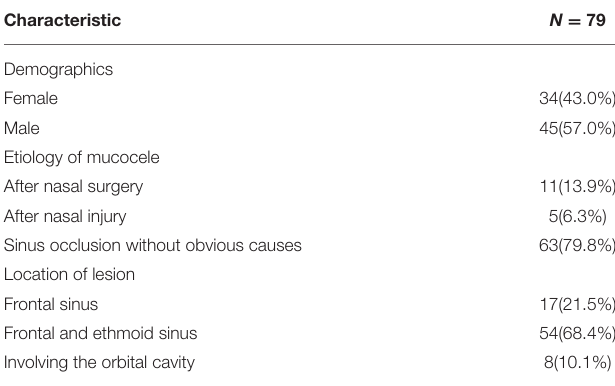
TABLE 1 | Patients’ demographic characteristics and etiology of